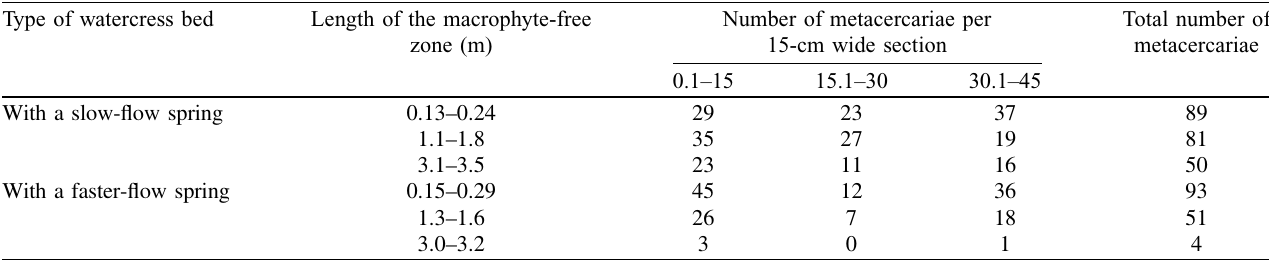
Table 3. Total number of Fasciola hepatica metacercariae in relation to the position of the host plant in the watercress bed. The width of the drainage furrow is expressed here in sections of 15 cm